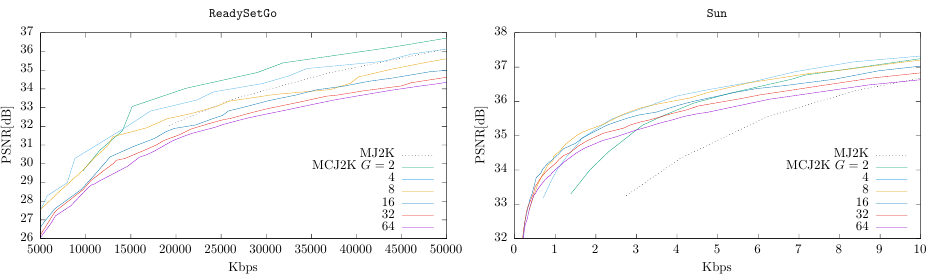
Figure 5. MCJ2K (OSLA) vs. MJ2K for different GOP sizes and sequences.